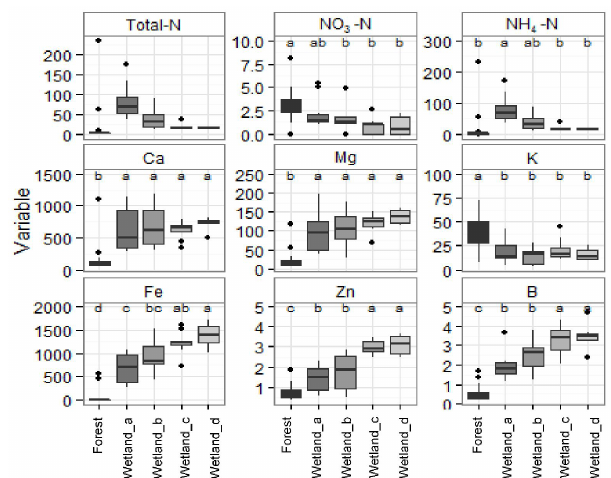
Figure 7. Box plots showing range of soil variables within each of the CH 4 clusters. Units represent probe supply rate (µg per 10cm 2 across burial period). Letters represent results from the Tukey fam- ily test statistic where clusters with similar letters are not signifi- cantly different from one another at 95% confidence level. Clusters Wetland_a to Wetland_d represent groups with sequentially increas- ing CH 4 emissions.